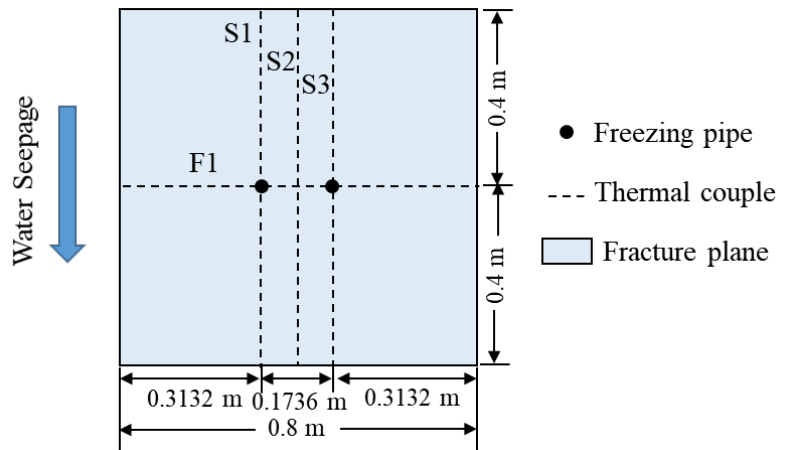
Table 2. Physical and thermodynamic parameters related to the rock sample (adapted from refer- ence [24]).